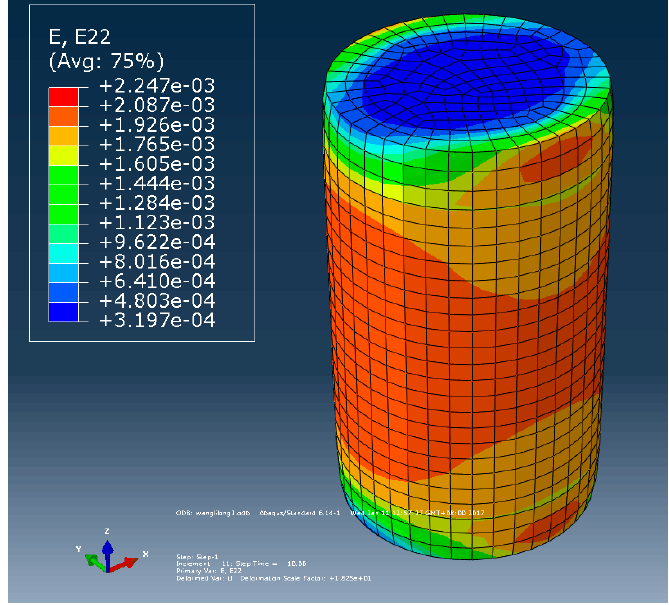
Figure 18. Simulation results.